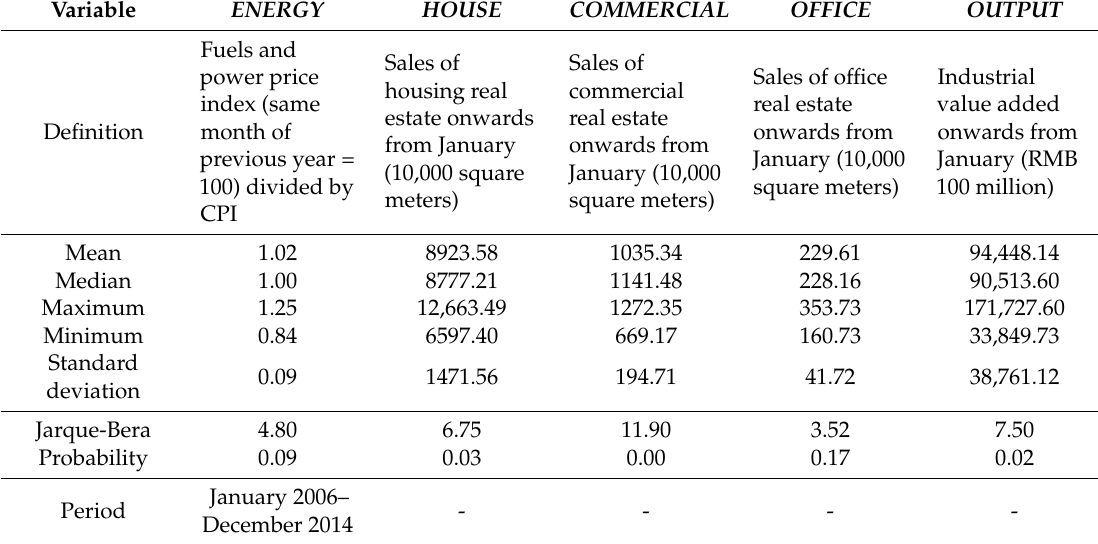
Table 1. Descriptive statistics of the